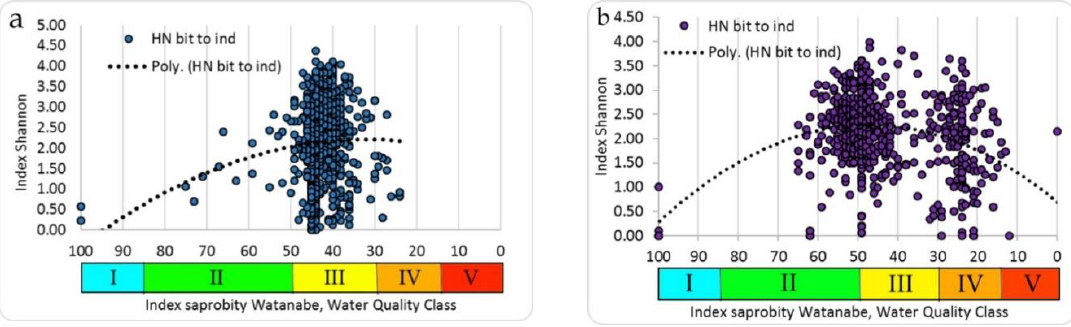
Figure 9. The distribution of Shannon species diversity indices in algae communities ( a ) and consumers ( b ) over a scale of Watanabe indices of saprobity in the studied water bodies of Ukraine.